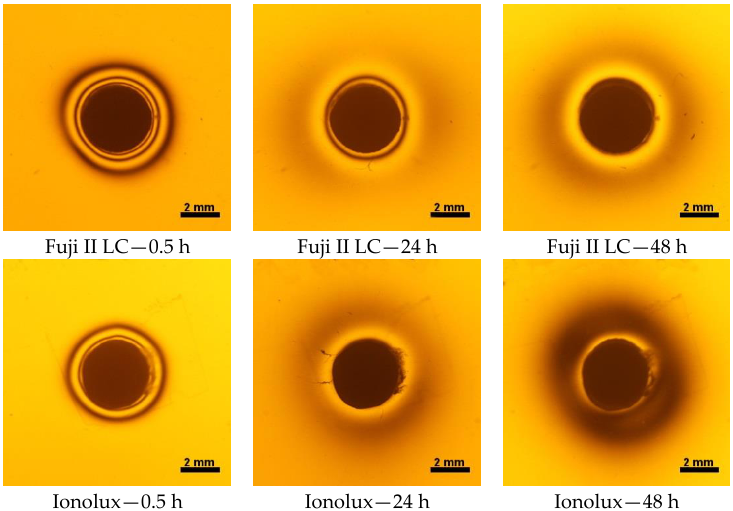
Figure 9. Isochromes in epoxy plate around Fuji II LC and Ionolux 0.5 h and after 24 and 48 h of water storage.